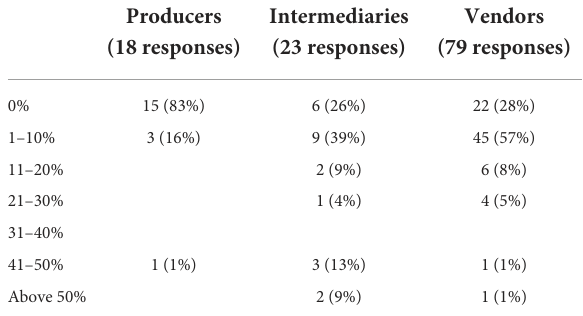
TABLE 3 Number (and percentage) of value chain actors reporting approximate volumes of milk spoiled each